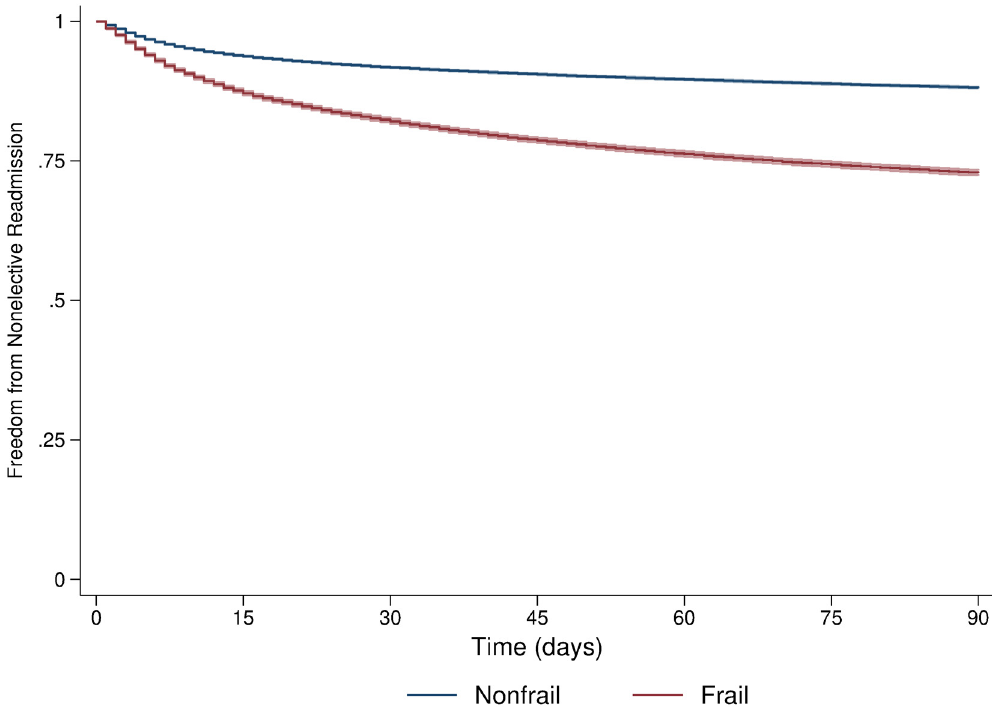
Fig 2. Freedom from unplanned readmission in Frail versus Nonfrail cohorts. Kaplan Meier curves with 95% confidence interval (shaded) include all EGS operations. Log rank P <